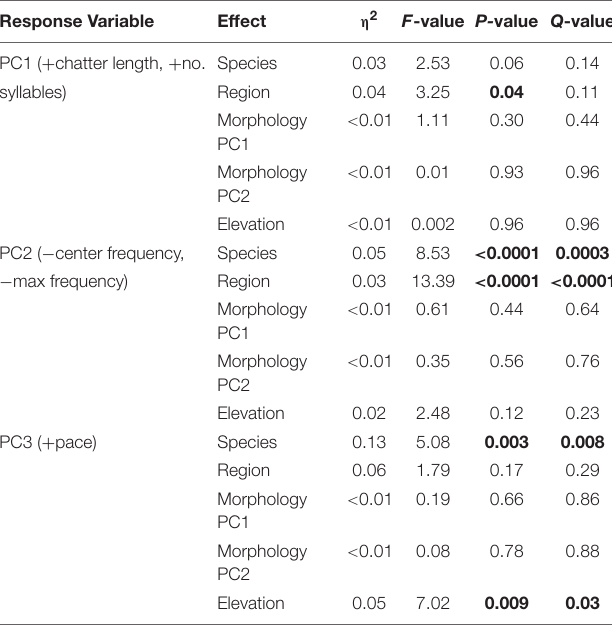
TABLE 4 | Linear model results for measures of variation in the general characteristics of indigobird chatter calls. Response